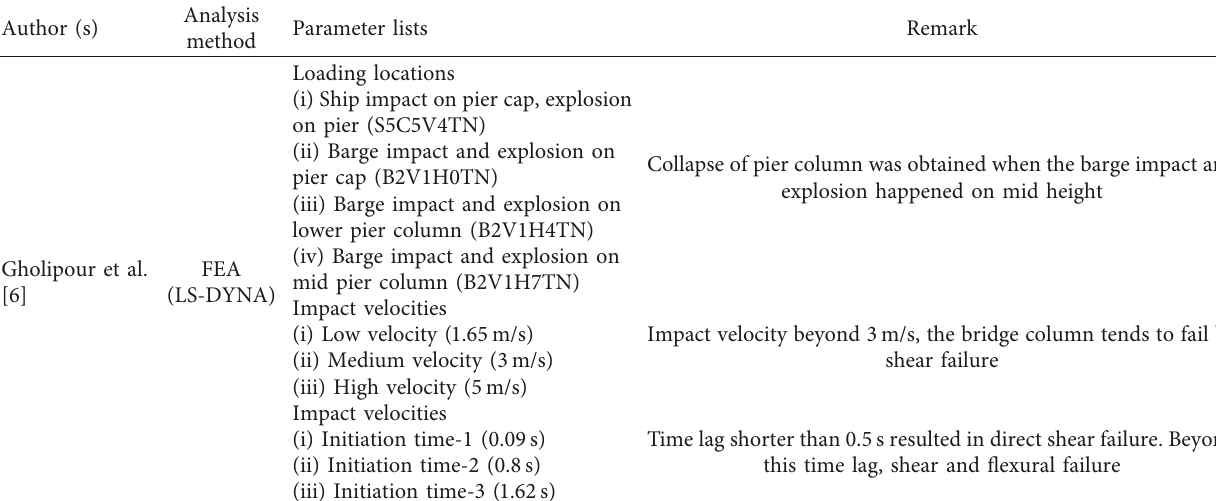
Table 4: Summary of different parameters and respective effects on RC columns prone to combined blast and impact